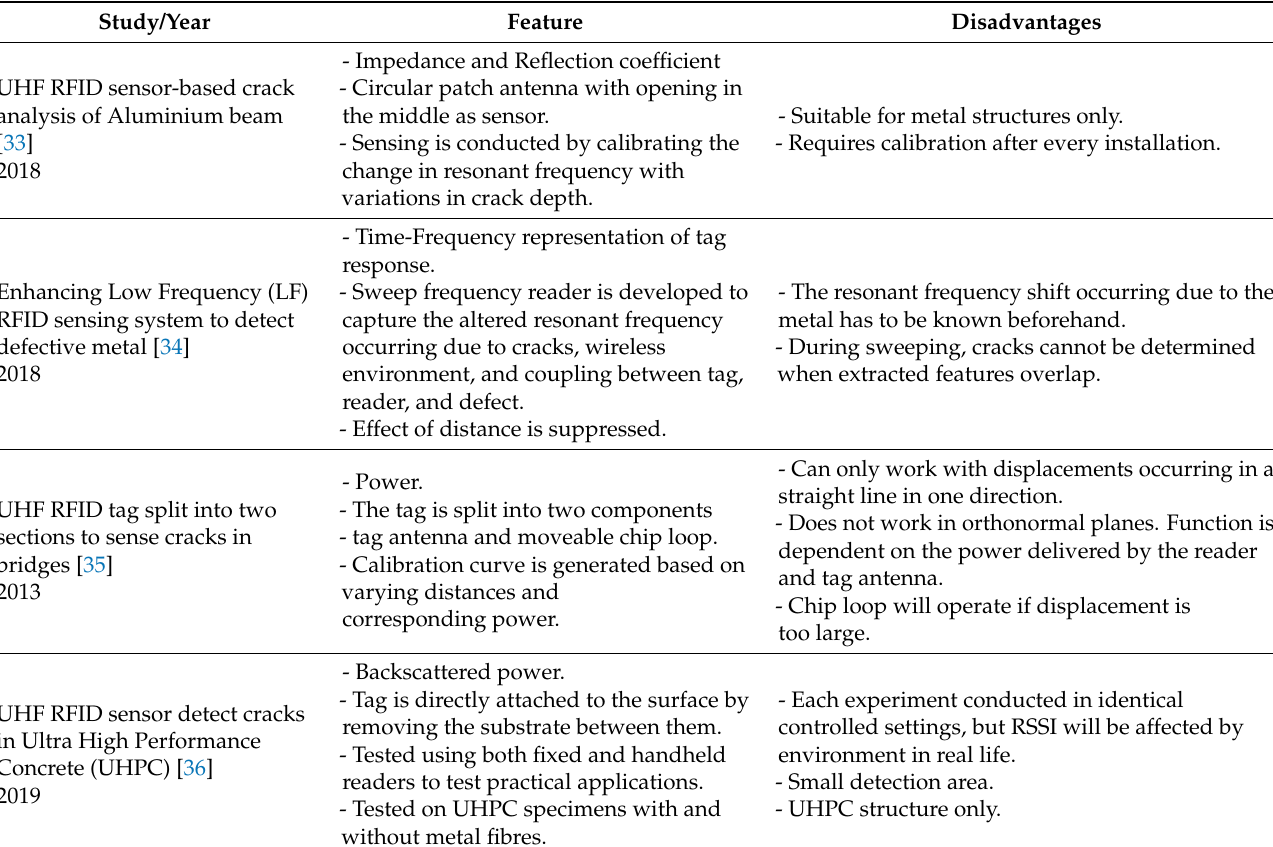
Table 2. Summary of Existing SHM Systems Based on Non-ML Based